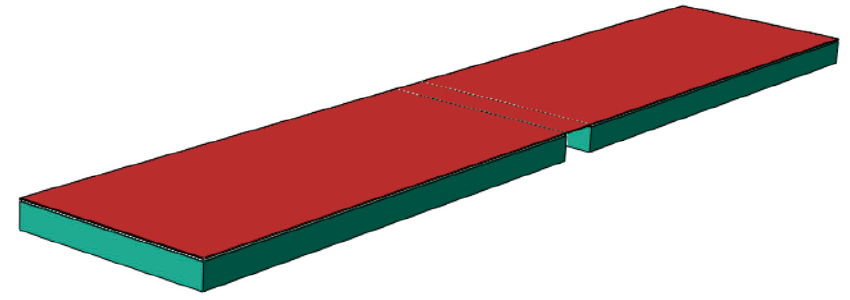
Figure 6. Finite element model.